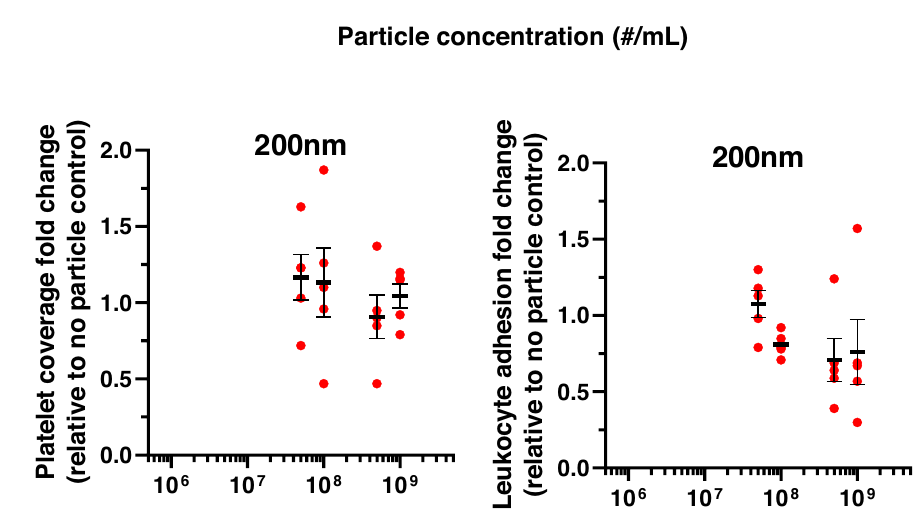
Fig. 2 | Micron-sized particles outperform nano-sized particles in modulating platelet and leukocyte adhesion to an in fl amed endothelium in human blood. Change in platelet and leukocyte adhesion to a damaged, in fl amed endothelium with the addition of untargeted ( a ) 4.5 µ m, ( b ) 500nm, or ( c ) 200nm IgG- conjugated polystyrene particles. N =5 independent donors were utilized for each particle treatment with 2 replicates per donor utilized for each (non-treatment) control. Statistical analyses were performed using two-way ANOVA with Sidak ’ s